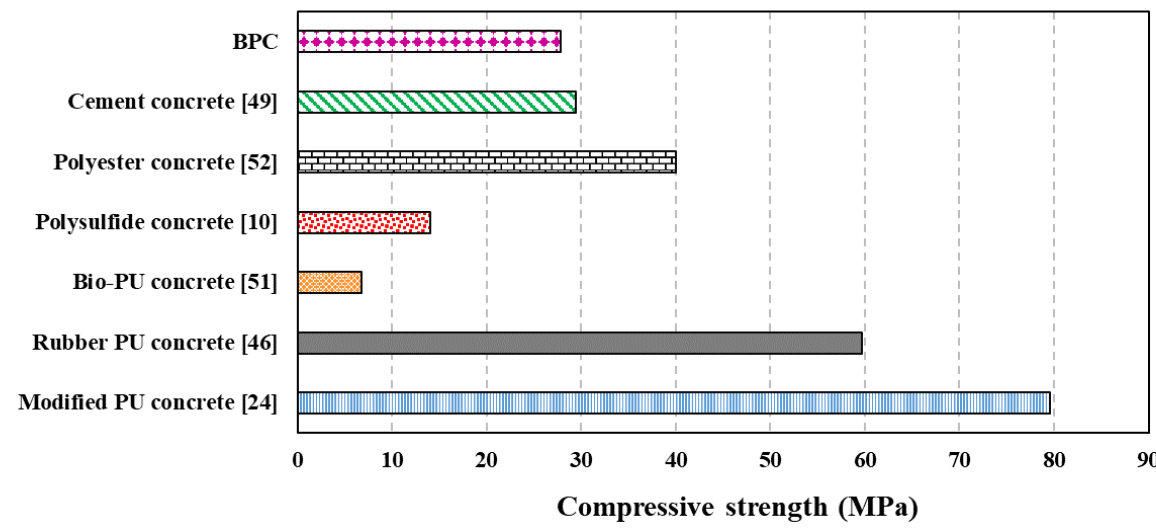
Figure 6. BPC compressive strength comparison with literature.